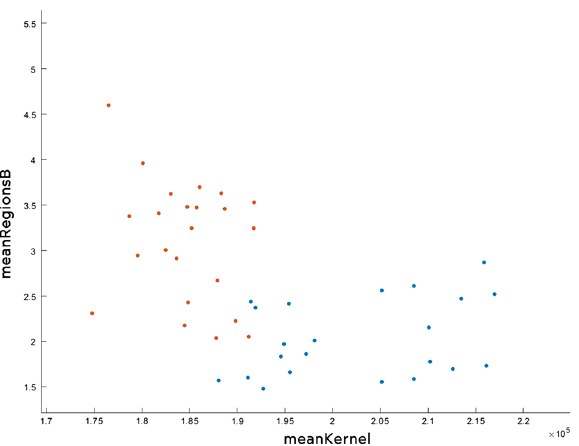
Figure 27. Correctly analysed data.